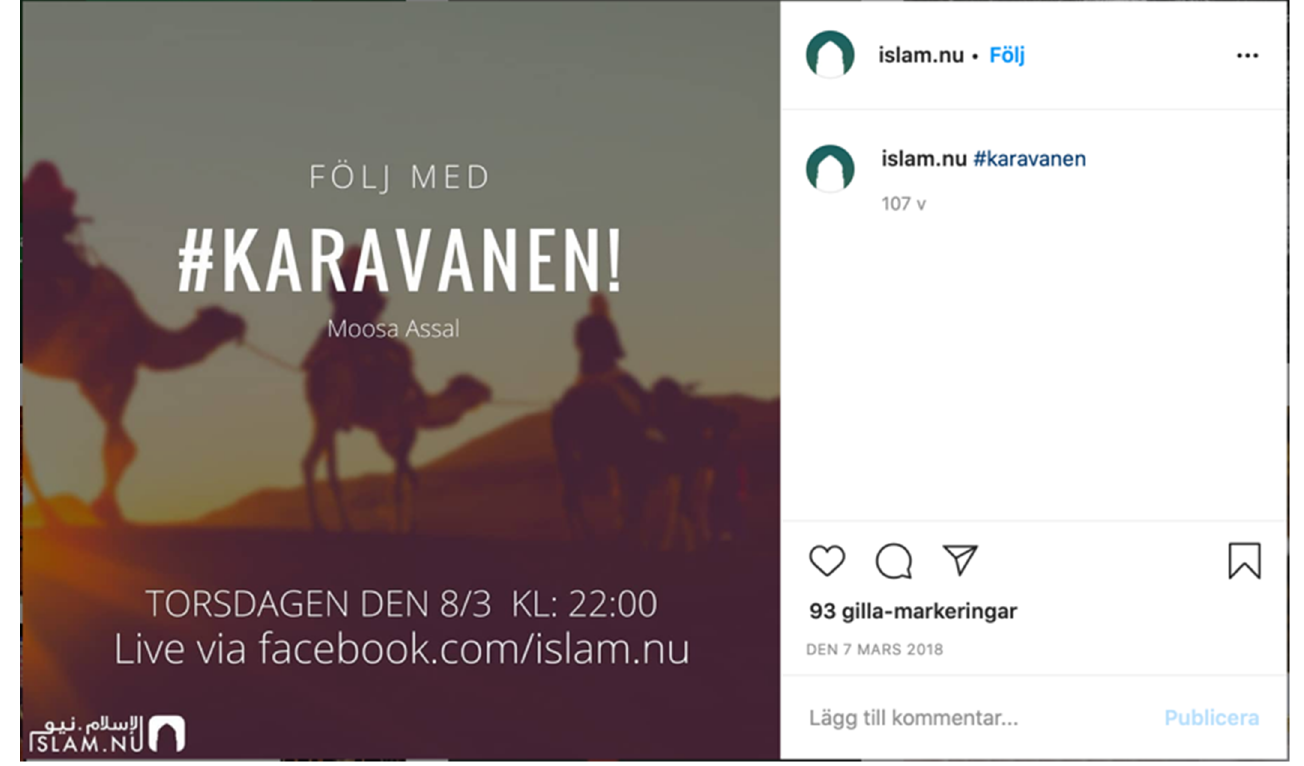
Figure 1. Islam.nu, Instagram, 7 March 2018.